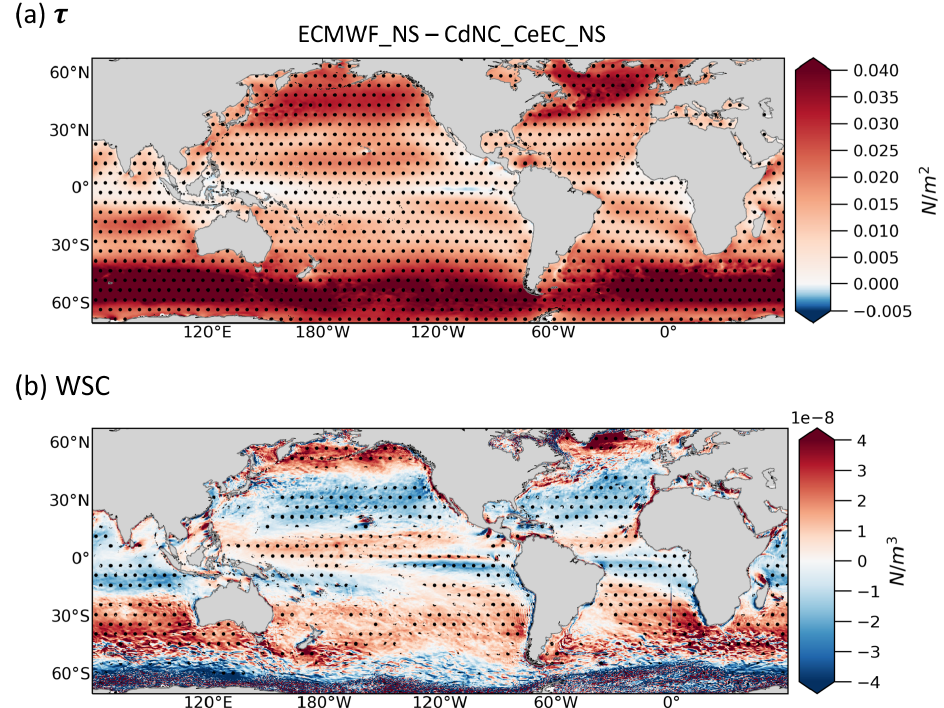
Figure 10. Annual mean differences in (a) wind stress ( τ ) and (b) wind stress curl (WSC) between ECMWF_NS and CdNC_CeEC_NS .